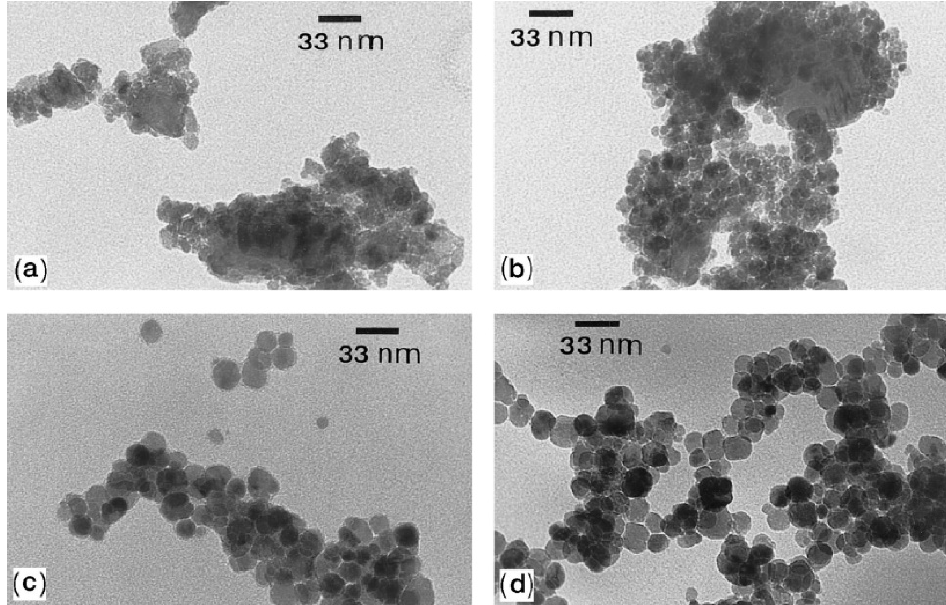
Figure 1. TEM images of a sample of γ -FeOOH during mechanochemical dehydration to hematite after: ( a ) 6 h, ( b ) 18 h, ( c ) 58 h, and ( d ) 70 h milling [57].